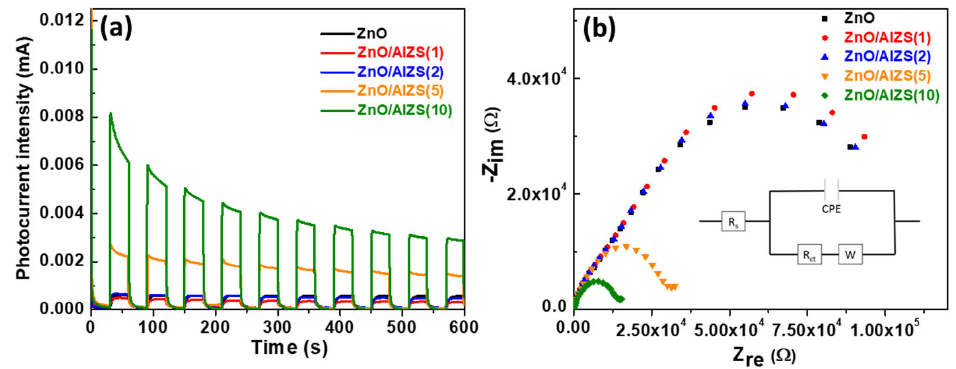
Figure 7. ( a ) Transient photocurrent response and ( b ) EIS Nyquist plots of ZnO and ZnO/AIZS photocatalysts (the inset is the Randles equivalent circuit used for fitting impedance spectra where Rs is the solution resistance, R CT the polarization resistance, W the Warburg impedance and CPE the constant phase element).